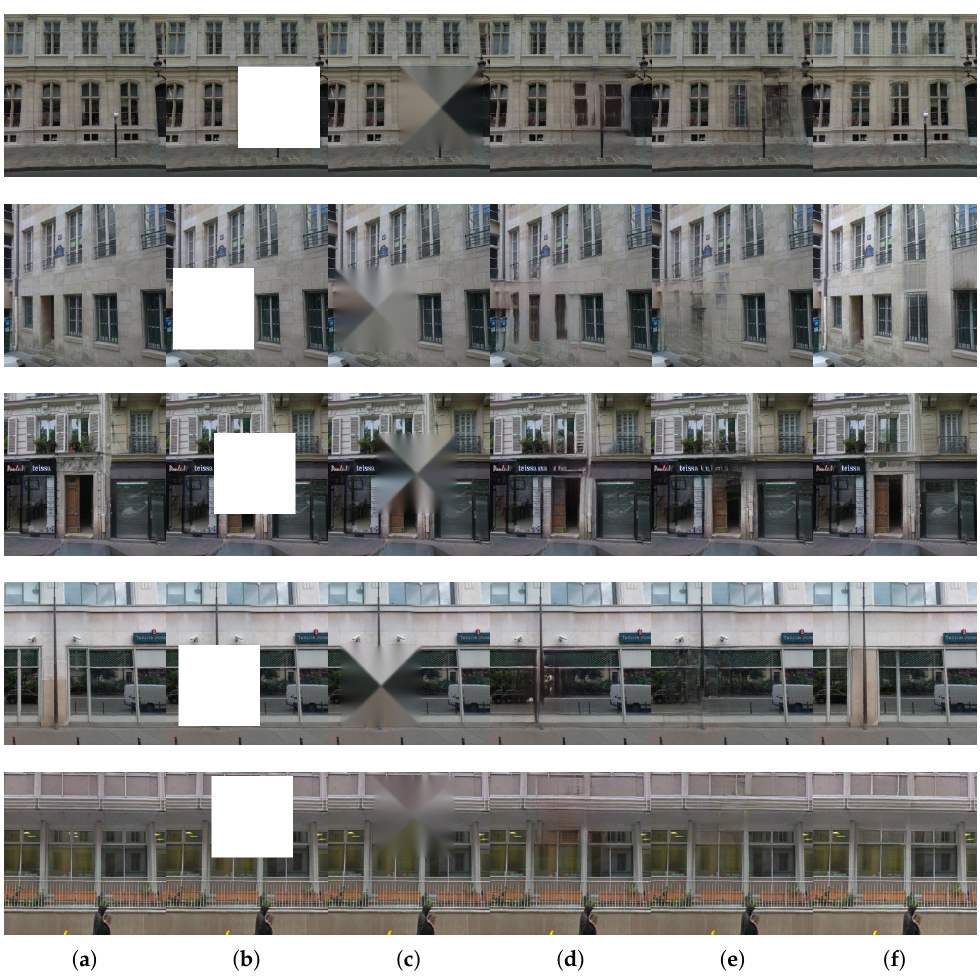
Figure 7. Comparison of qualitative results with the existing methods on random regular masked Paris StreetView. ( a ) ground truth images; ( b ) masked input images; ( c ) results of the FMM; ( d ) results of the GMCNN; ( e ) results of the EdgeConnect; ( f ) results of PIC-EC, best viewed with